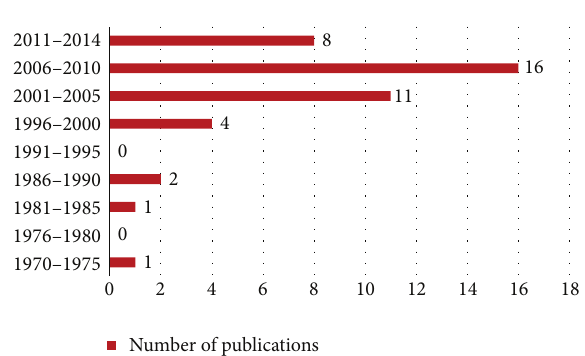
Figure 2: Number of publications per 5